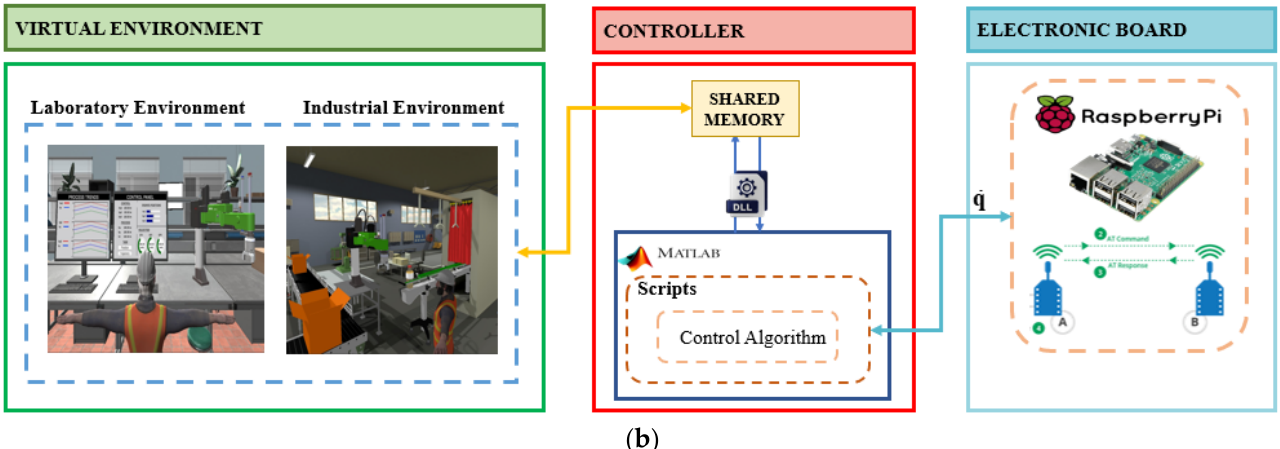
Figure 3. Virtualization scheme of the environments and the Scara SR-800 robot for the training system using the Full Simulation technique and the HIL technique. ( a ) Training system applying the Full simulation technique through a virtual environment. ( b ) Training system using the Hardware – in – the – Loop (HIL) technique through a virtual environment.